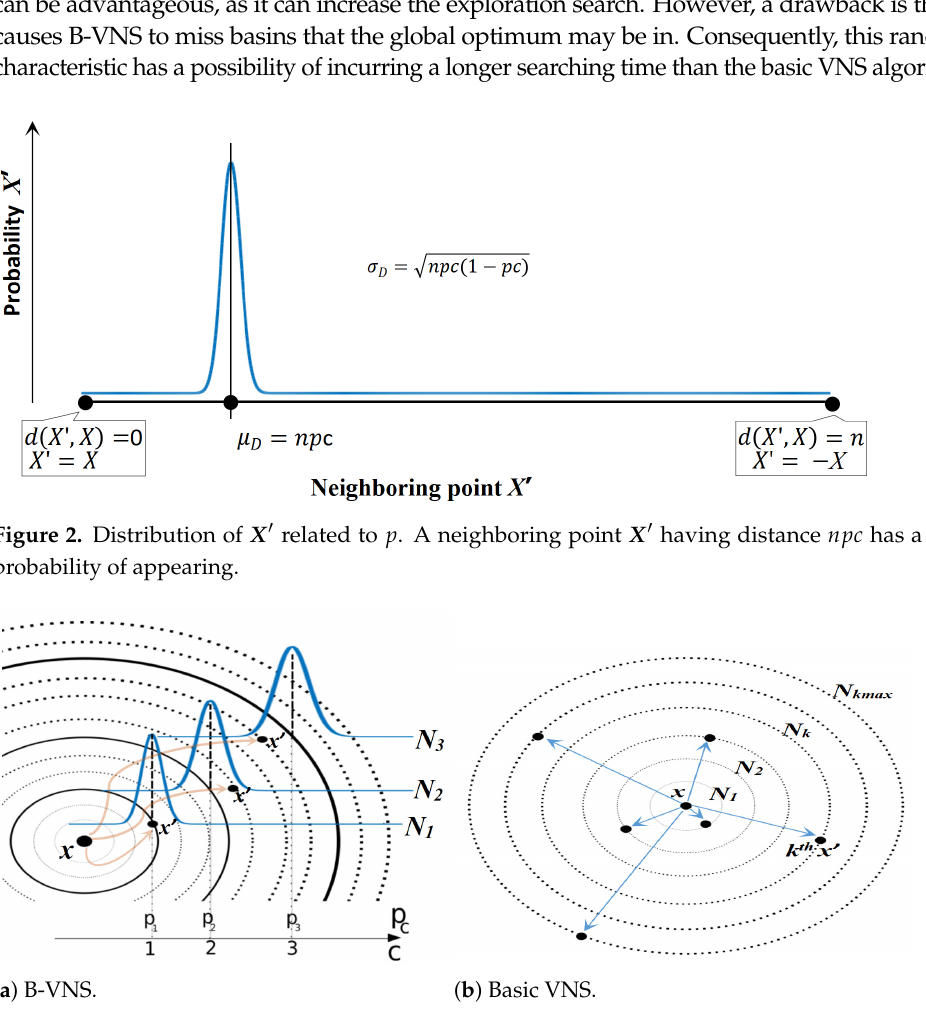
Figure 3. Neighborhood structure. ( a ) The neighborhood structure of B-VNS becomes wider accord- ing to probability p c , while ( b ) the neighborhood structure of basic VNS becomes wider according to variable k = 1,2,..., k max